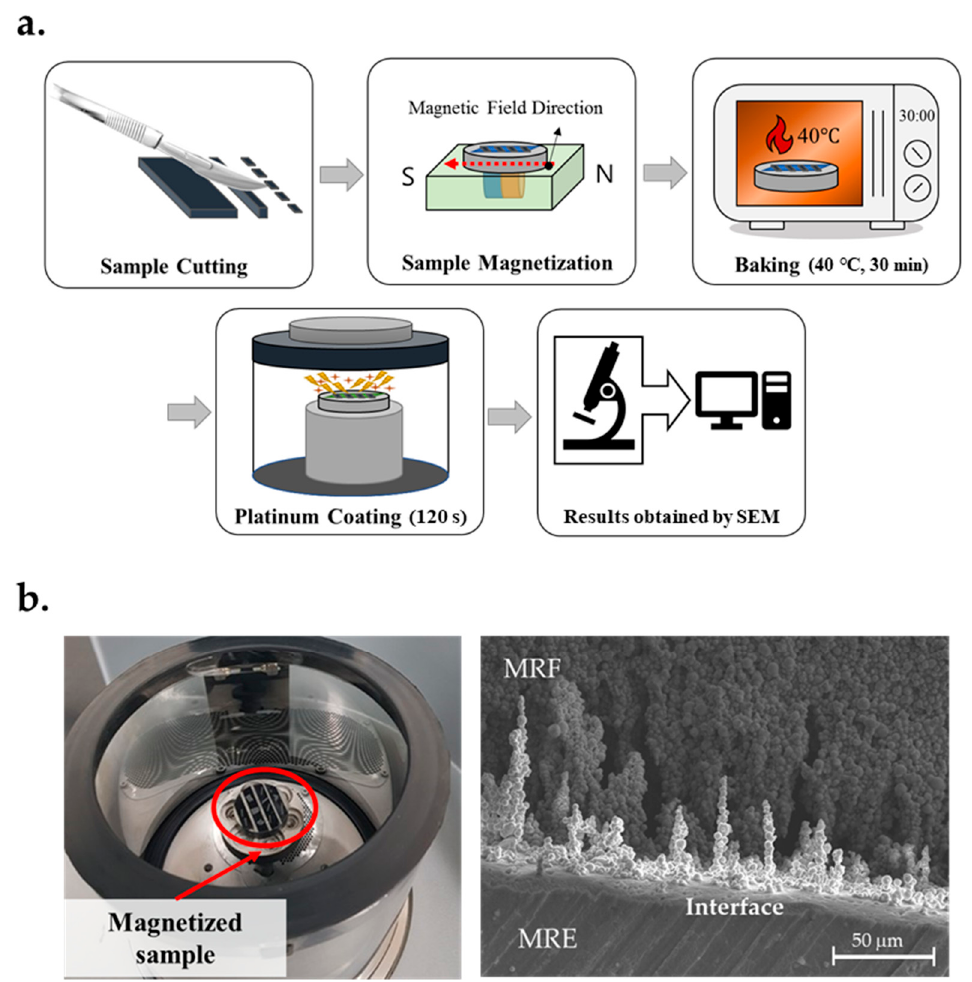
Figure 6. Magnetic-responsive microsized CIP steps of the soft composites: ( a ) SEM procedure and ( b ) magnetized sample and SEM image. Table 1. Mean and standard deviation of the weight per specimen.